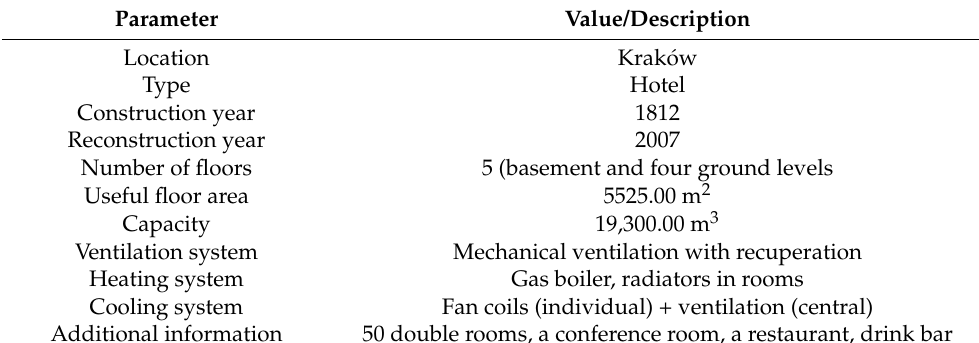
Table 1. Characteristics of analyzed building.